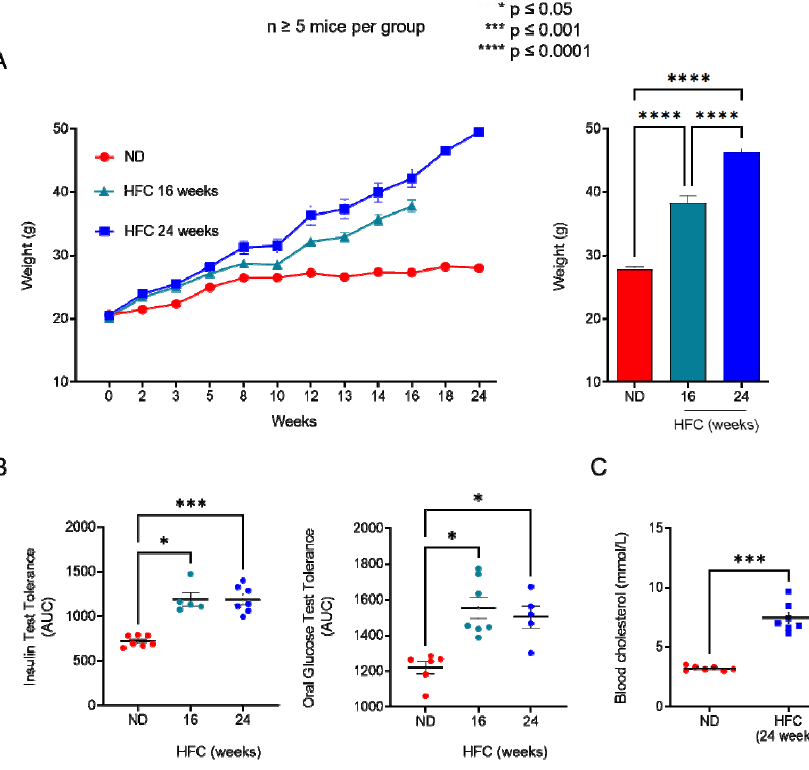
Figure 4. Diet-induced hypercholesterolemia in B6 mice. ( A ) Mean body weight of mice fed either a normal diet (ND) or a high-fat diet (HFC) presented as the weekly evolution (left panel) or following 16 or 24 weeks of the diet (right panel). ( B ) Insulin tolerance test (ITT, left panel) and oral glucose tolerance test (OGTT, right panel) performed on mice fed either a normal diet or a high-fat diet maintained for 16 and 24 weeks. ( C ) Level of circulating cholesterol in the blood of mice fed either a normal diet or a high-fat diet maintained for 24 weeks. Data are expressed as the mean of percentages (±SEM, n ≥ 5 mice). Asterisks denote statistically significant differences: * p ≤ 0.05, *** p ≤ 0.001, **** p ≤ 0.0001.